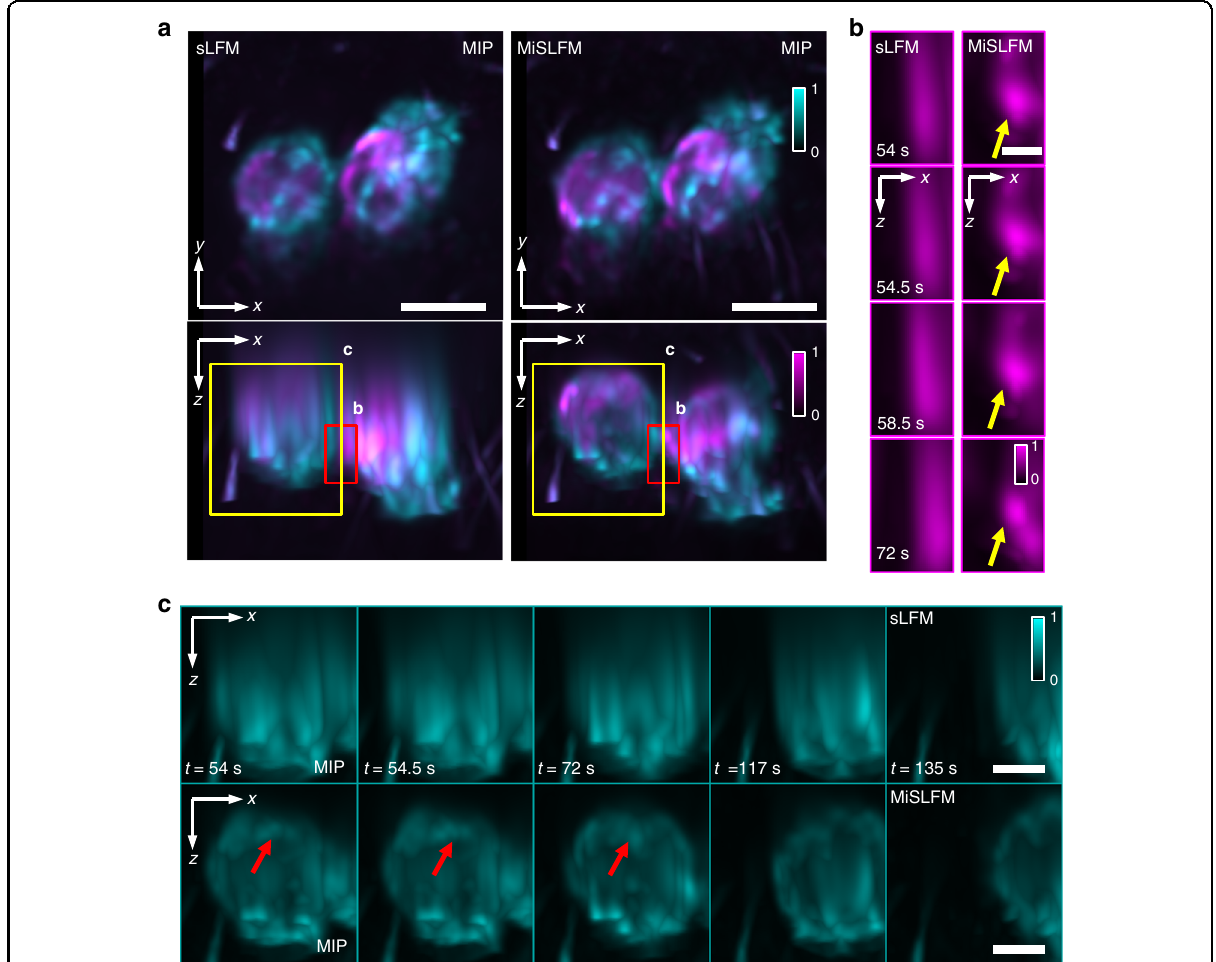
Fig. 4 Two-color volumetric imaging of contractile vacuoles and the cell membrane of Dictyostelium discoideum. a MIPs of the reconstructed contractile vacuole (magenta, 488 nm) and cell membrane (cyan, 561 nm), at a 2-Hz volume rate over 50 µm × 50 µm × 40 µm for sLFM and MiSLFM under 1.71 mW mm − 2 (488nm) and 1.55 mW mm − 2 (561nm) illumination, demonstrating axial resolution improvement for MiSLFM under a 60×/1.1 NA objective. b Magni fi ed areas marked by red boxes in ( a ) by sLFM (left) and MiSLFM (right). Yellow arrows mark the vesicles, which show precise axial localizations in MiSLFM. c Magni fi ed areas marked by yellow boxes in ( a ) by sLFM (top) and MiSLFM (bottom). Red arrows mark a point in the upper cell membrane movement, which could not be observed in sLFM and could be clearly visualized in MiSLFM. Scale bars in ( a ) is 10 µm, in ( b ) is 2 µm, in ( c ) is 5